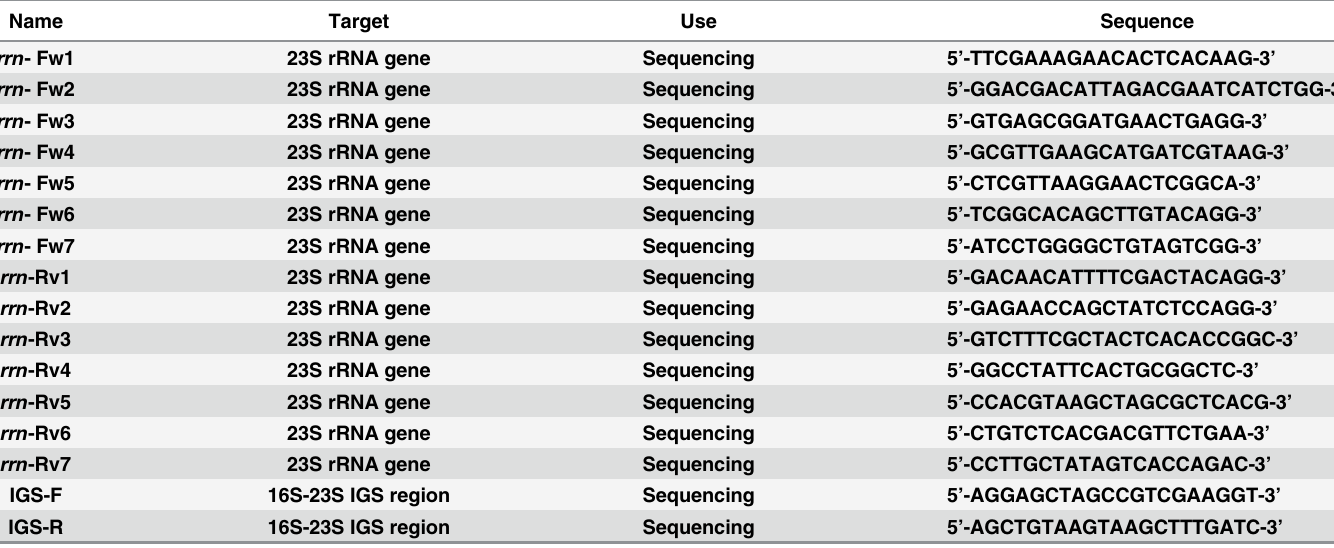
Table 2. Primers used in this